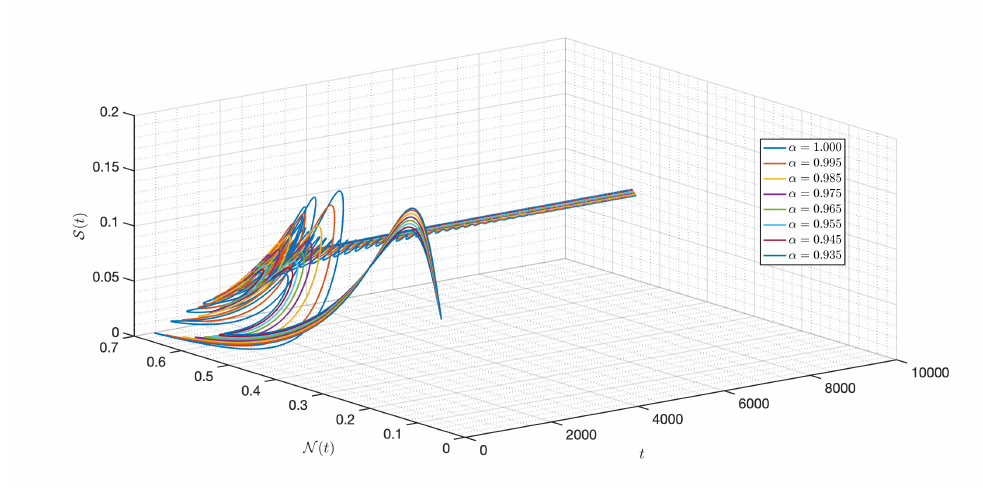
Figure 7. Dynamic of the model (3) for different parameters in Case I .